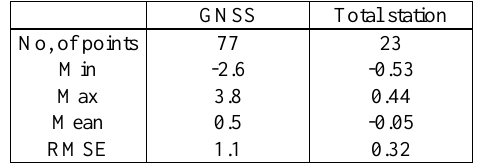
Table 3. Statistics of the height errors found (cm) in the altimetric check points (GNSS and total